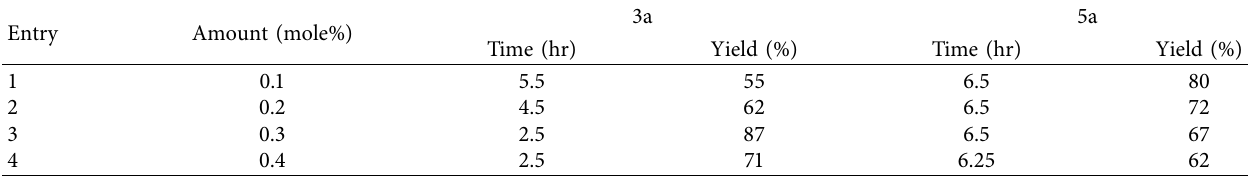
Table 3: Screening of catalyst loading.